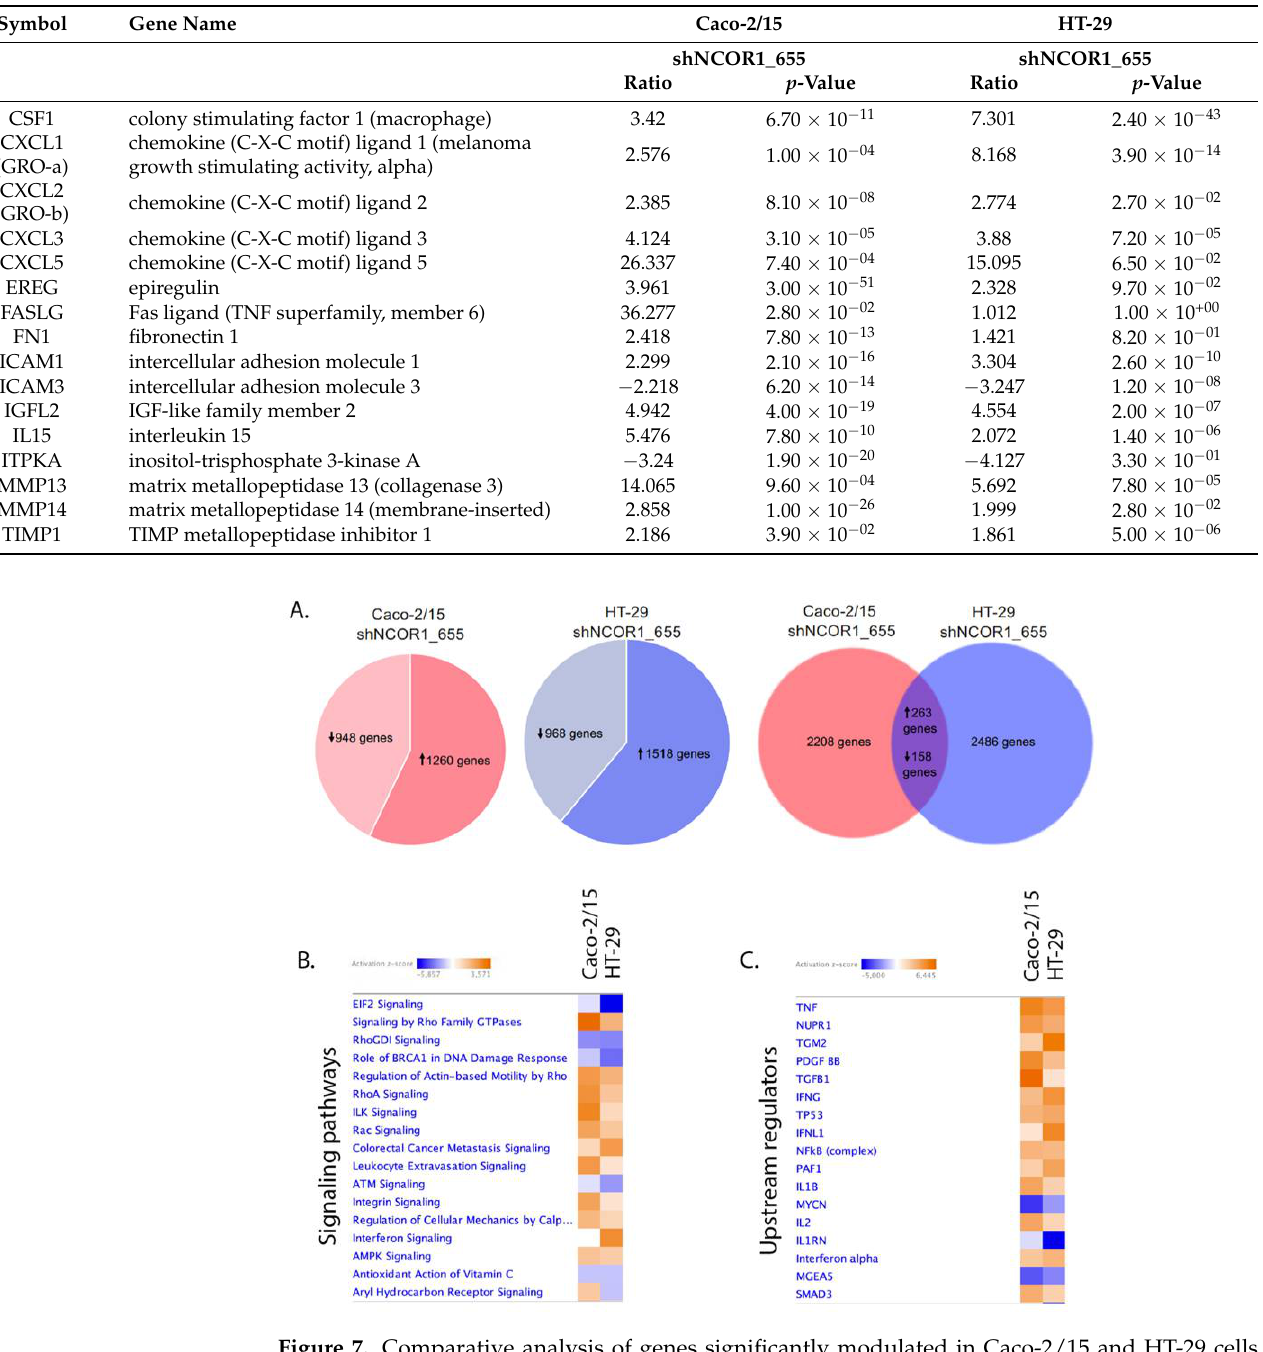
Figure 7. Comparative analysis of genes significantly modulated in Caco-2/15 and HT-29 cells depleted for NCOR1 expression. Total RNA from shNCOR1_655 and shNonTarget adherent cells was isolated 7 days after lentiviral infection and RNA-seq was performed. ( A ) A Venn diagram is used to display comparisons of gene transcript levels that were significantly modulated more than twofold ( p < 0.05) between Caco-2/15 and HT-29 cells. IPA analysis showing altered signaling pathways ( B ) or upstream regulators ( C ) based on differentially expressed genes associated with the loss of NCOR1 expression in both Caco-2/15 and HT-29 cells. The color range indicates predicted activation state where a value of z-score ≥ 2 corresponds to a significant prediction of activation (orange), whereas a value ≤ − 2 is associated with inhibition